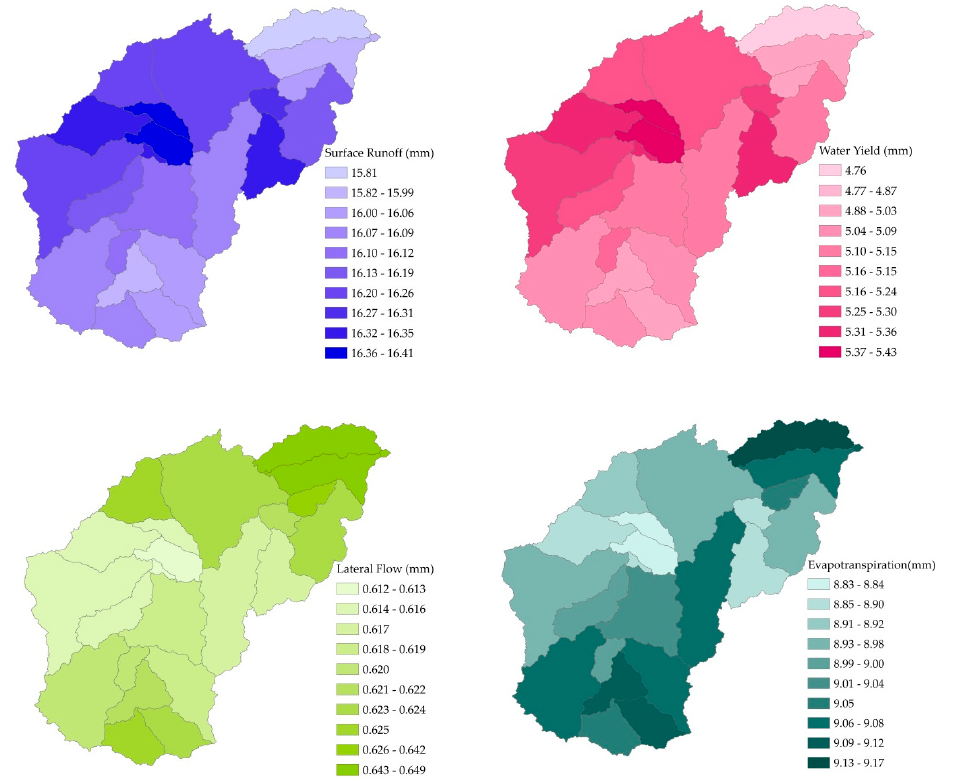
Figure 7. Spatial distribution of hydrologic components at the sub ‐ basinal scale between 2000 and 2013.